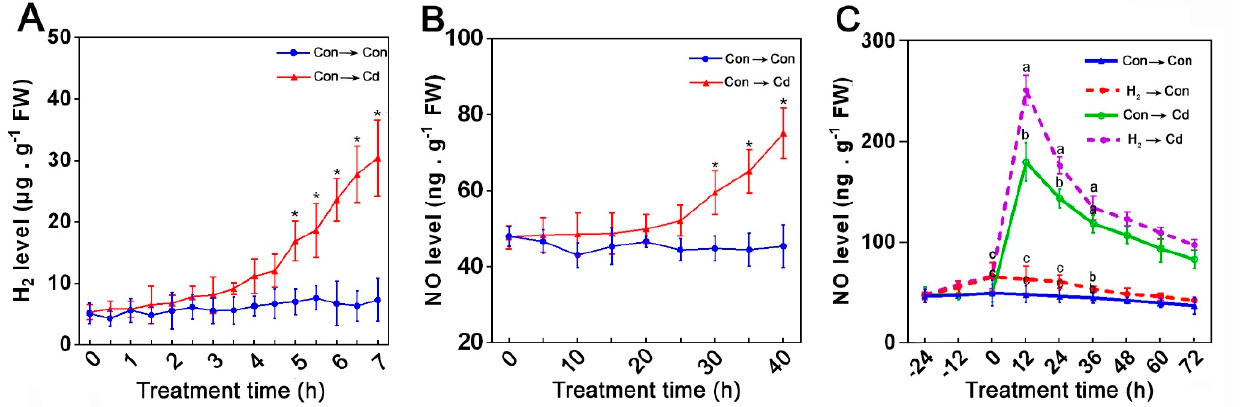
Figure 3. Effects of Cd and H 2 fumigation treatments on the endogenous H 2 and NO levels in mycelia. Early signals of H 2 and NO were observed in the mycelia grown on solid CYM with or without 1.75 mM Cd for the indicated time points ( A , B ). Additionally, a four-day time course of endogenous NO level was tracked in the mycelia ( C ). On the 3rd day, two-day-old mycelia were either pre-treated or not with 3% H 2 for 24 h and then were transferred into control or stressed CYM media and grown for 72 h. H 2 and NO levels were measured by GC and Griess reagent assay, respectively. Asterisks * indicate the significant difference at every time point relative to Con → Con according to t -test at p < 0.05 ( A , B ), and letters indicate significant difference at every time point relative to Con → Con according to one-way ANOVA with multiple comparison using Tukey’s test at p < 0.05 ( C ).